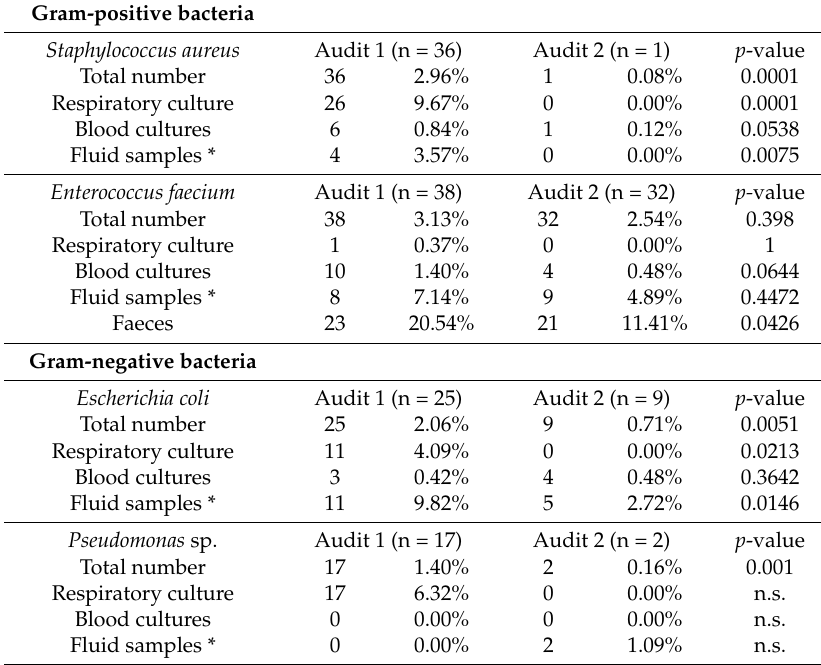
Table 1. Isolates collected grouped by their absolute numbers and their source of